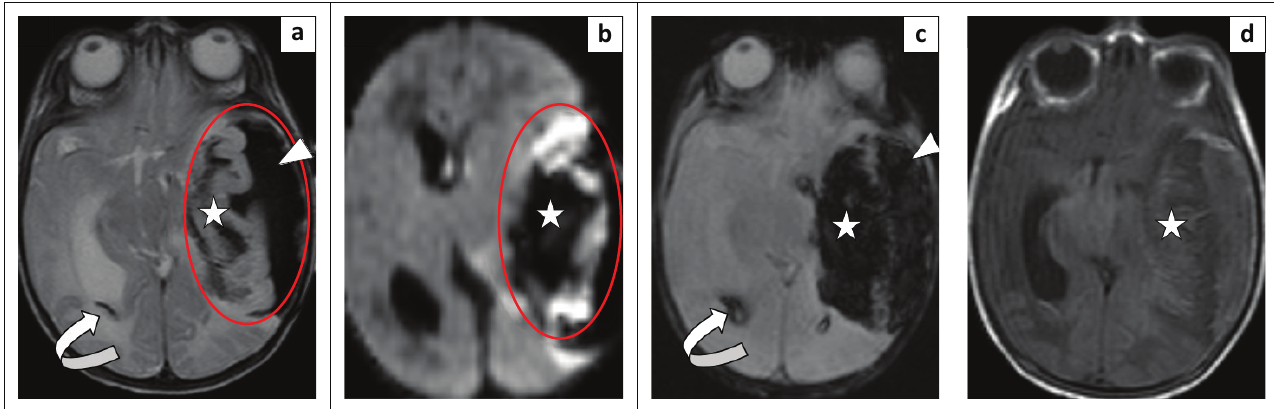
FIGURE 2: Axial MRI sequences. T2-weighted (a), diffusion-weighted imaging (DWI) (b), gradient recalled echo (GRE) (c) and T1 weighted (d) reveal left temporal T2 hypointense subpial haemorrhage with blooming on GRE. Left temporal lobe intraparenchymal extension (star), intraventricular extension and hydrocephalus noted (curved arrow). The T2-weighted and DWI sequences demonstrate the classic ‘yin-yang sign’ of subpial hypointensity and underlying cortical hyperintensity (circled in red).